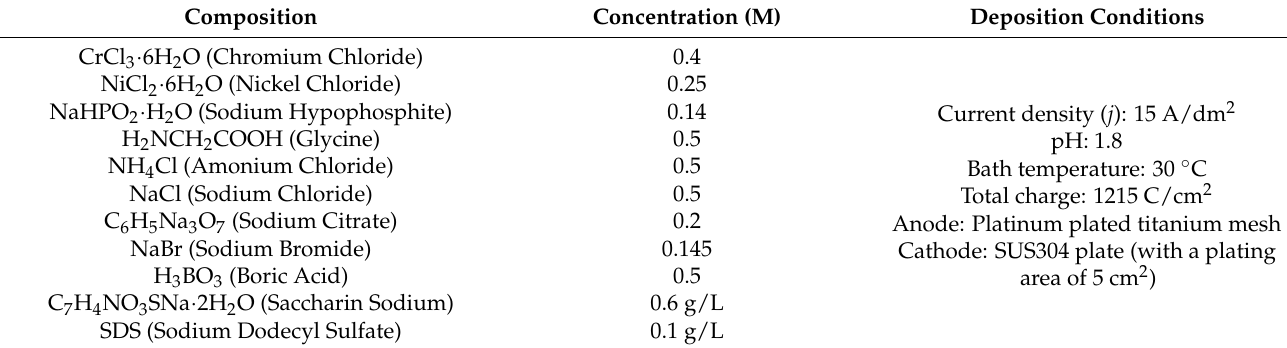
Table 2. Bath formulation and deposition conditions for electrodeposition of Ni-Cr-P alloy coating.